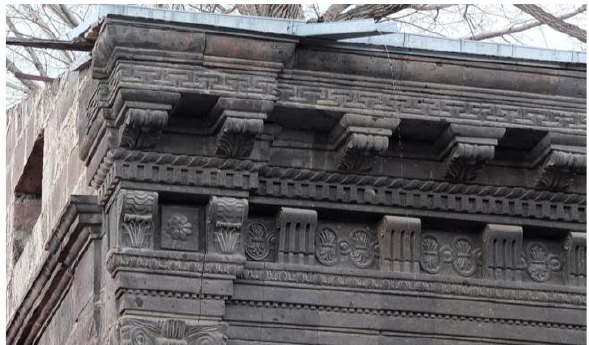
Figure 15. Interrupted axes of corbels in the lateral parts of the “House with two cornices” facade. Photo by the author, 2018.